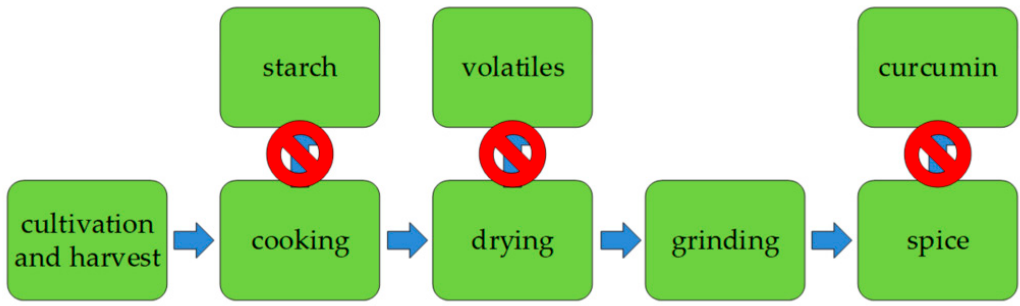
Figure 2. Loss of potential products by the restricted focus on traditional process technology.